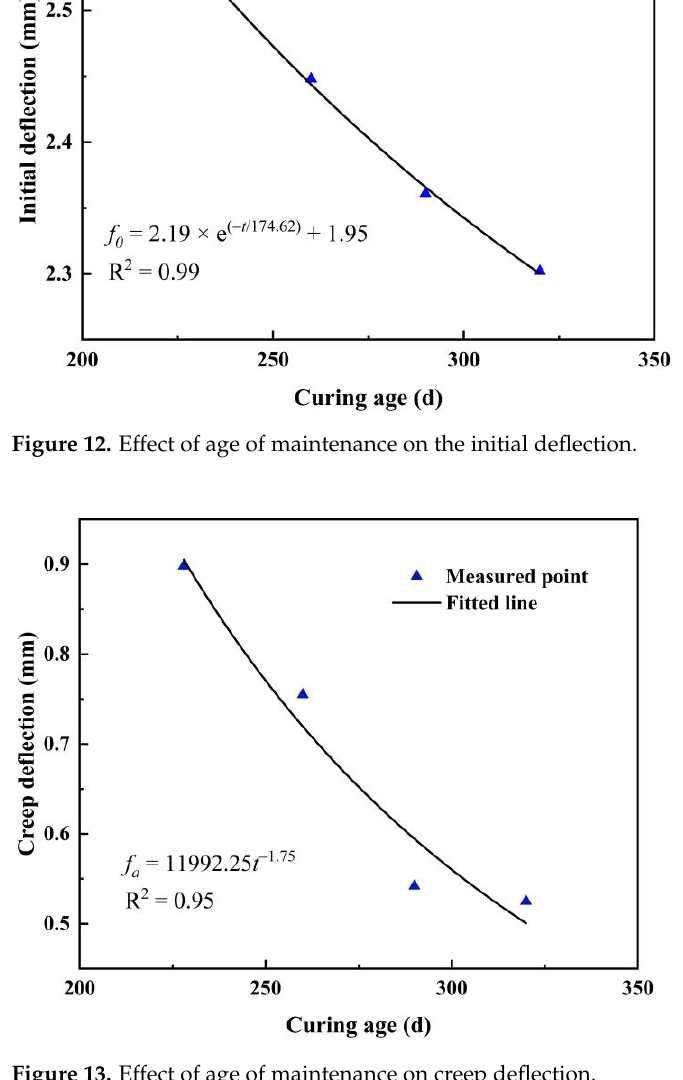
Figure 12. Effect of age of maintenance on the initial deflection.